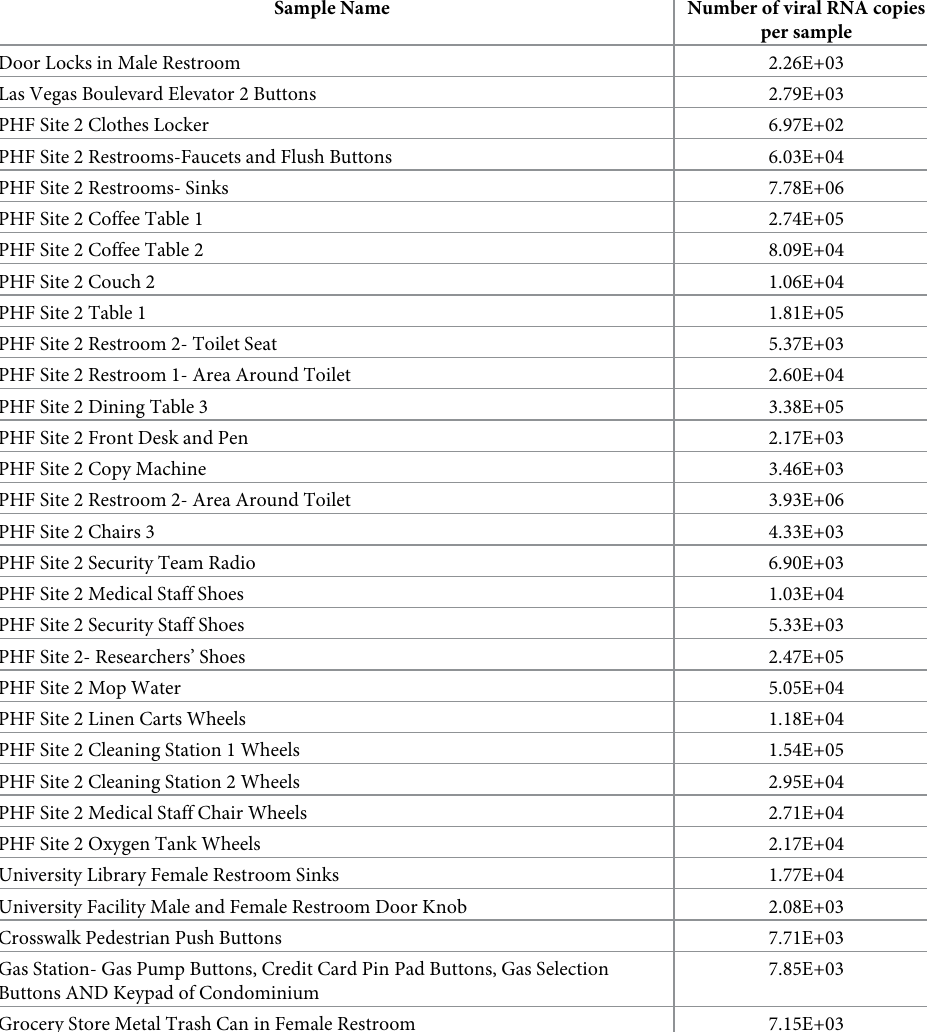
Table 2. SARS-CoV-2 positive samples and RNA copies per